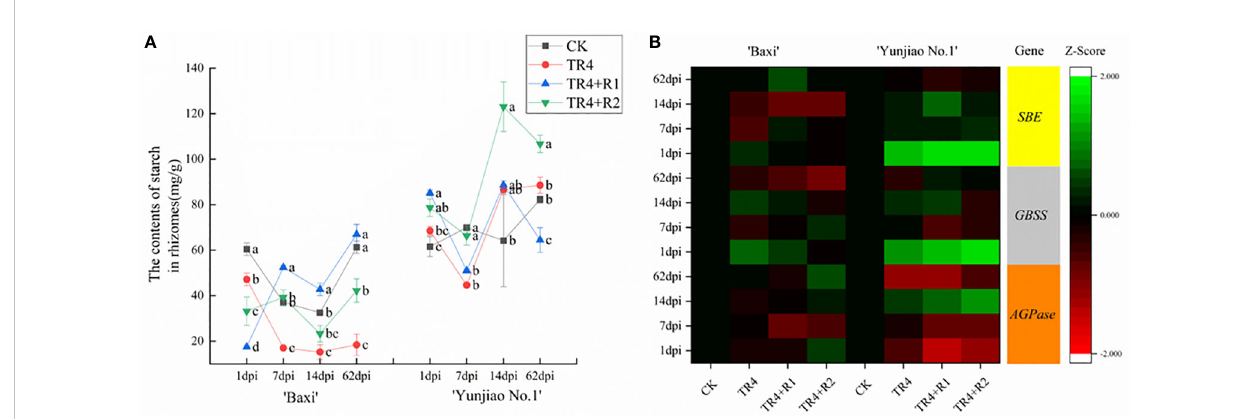
FIGURE 8 (A) Contents of starch in banana corms at different time points past inoculation TR4 (1 dpi, 7 dpi, 14 dpi and 62 dpi). The data represents three independently repeating values. Based on Duncan ’ s multiple range test, a signi fi cant difference was determined at P<0.05. Lowercase letters a, b, c, d mark signi fi cant differences: the same letter means no difference during the same period, while different letters indicate a signi fi cant difference. Error bars represent ± standard deviation. (B) Relative expression levels of key genes for starch synthesis in corms at 1dpi to 62dpi. The heat map illustrates the double change in the expression(log10) of key genes for starch synthesis in the corm at 1dpi to 62 dpi. Different color means induced or repressed gene expression (Red indicates down-regulation of gene expression; green indicates up-regulation of gene expression; black indicates no effect on gene expression). Three biological replicates and three technical replicates were used in data analysis. AGPase, ADP-glucose pyrophosphorylase; SBE, Starch branching enzyme; GBSS, granule-binding starch